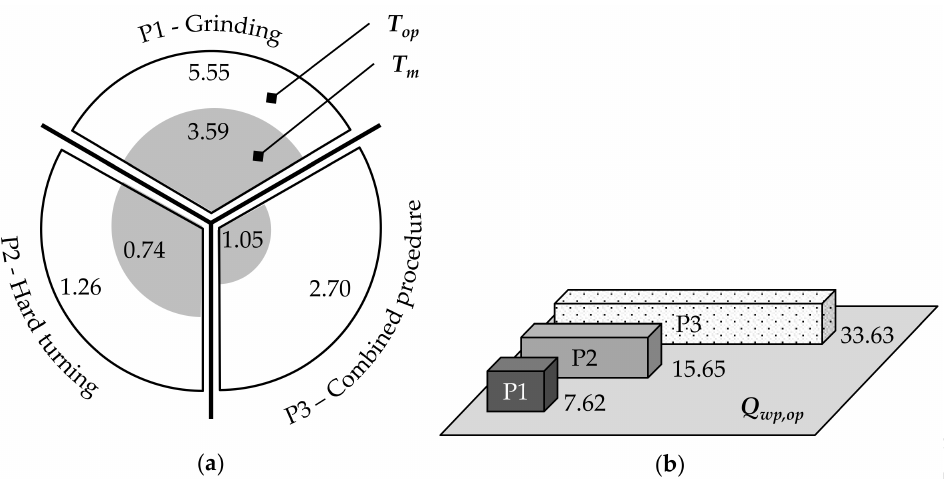
Figure 3. ( a ) rate of machining times within operation time ( T op = 100%); ( b ) practical material removal rates of the three procedures.